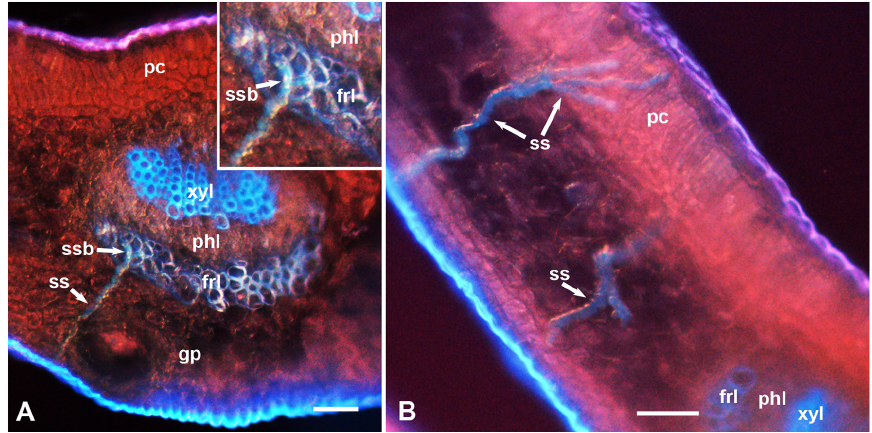
Figure 3. Epifluorescence micrographs showing stylet sheaths (ss) of D.citri in cross sections of the midrib (A) or leaf blade (B) of the relatively resistant (UN-3881) plants. Abbreviations: frl, lower fibrous ring; gp, ground/spongy parenchyma; pc, palisade parenchyma cells; phl, lower phloem; ss, stylet sheath; ssb, part of stylet sheath branching inside the fibrous ring; xyl, lower xylem. Scale bars=50 m m.